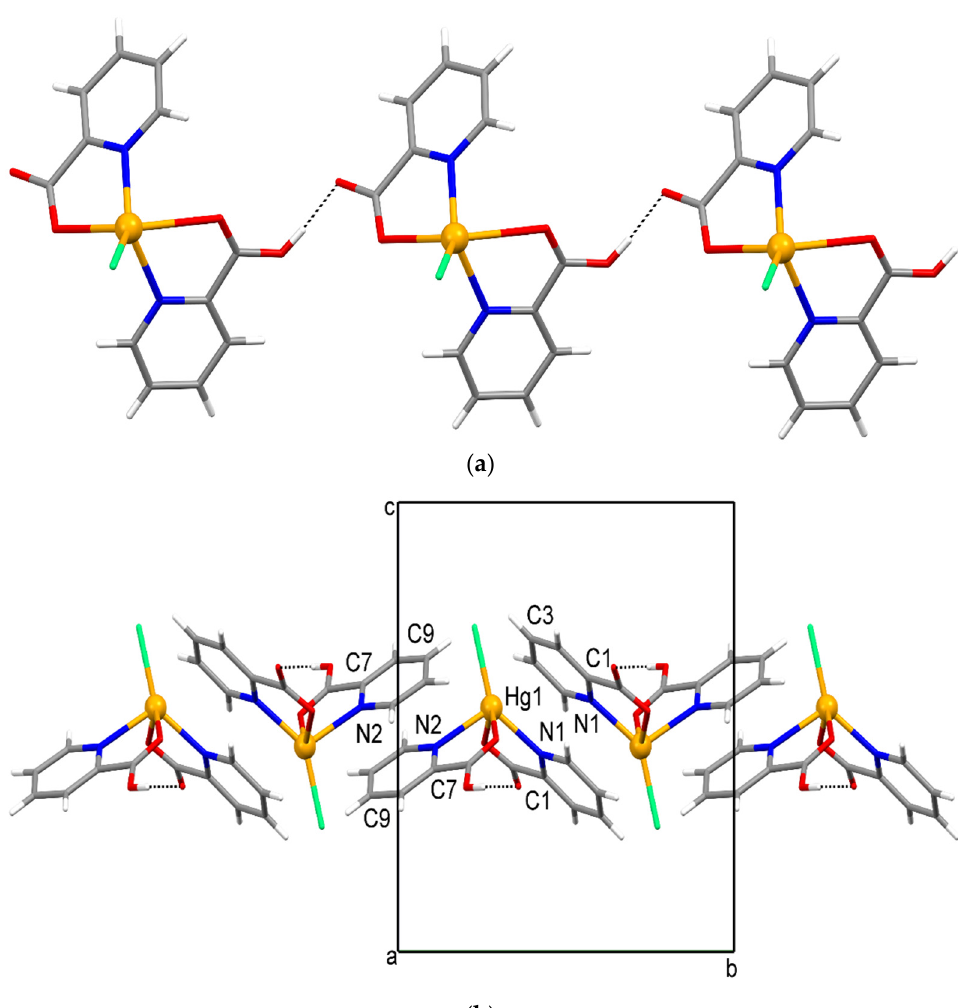
Figure 3. A hydrogen-bonded chain in the structure of [HgCl(pic)(picH)] ( 2 ). The [HgCl(pic)(picH)] molecules are connected by the intermolecular O–H ⋅⋅⋅ O hydrogen bonds (represented by the dotted lines) along the [1 0 0] direction, giving rise to a hydrogen-bond chain motif C11(8) ( a ). A fragment of the structure of [ HgCl(pic)(picH) ] ( 2 ) viewed down the [1 0 0] direction. The hydrogen-bonded chains of [ HgCl(pic)(picH) ] , represented as monomeric molecules in this projection, are connected along the [0 1 0] direction by π – π interactions between symmetry-related picolinic acid pyridine rings (N2/C7–C11) and between picolinate pyridine rings (N1/C1–C5) and chelate rings (Hg1/O1/C6/C1/N1); the selected atoms of the pyridine rings in the interactions are labeled ( b ). PXRD was used to confirm the phase purity and bulk composition of compounds